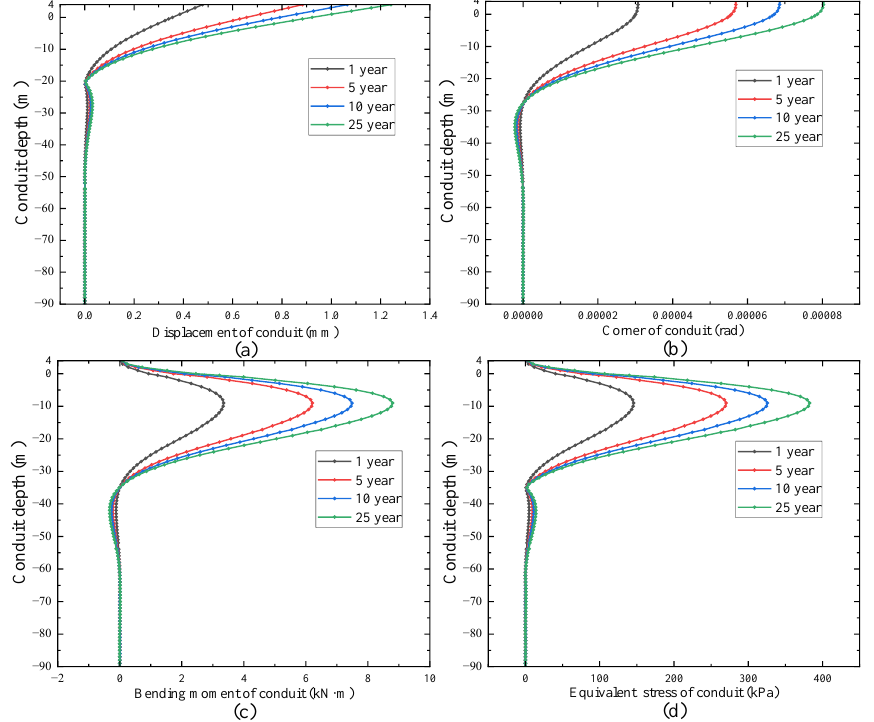
Figure 4. ( a ) Effect of sea state return period on conductor displacement, ( b ) Effect of sea state return period on conductor rotation angle, ( c ) Effect of sea state return period on conductor bending moment, ( d ) Effect of sea state return period on conductor equivalent force.